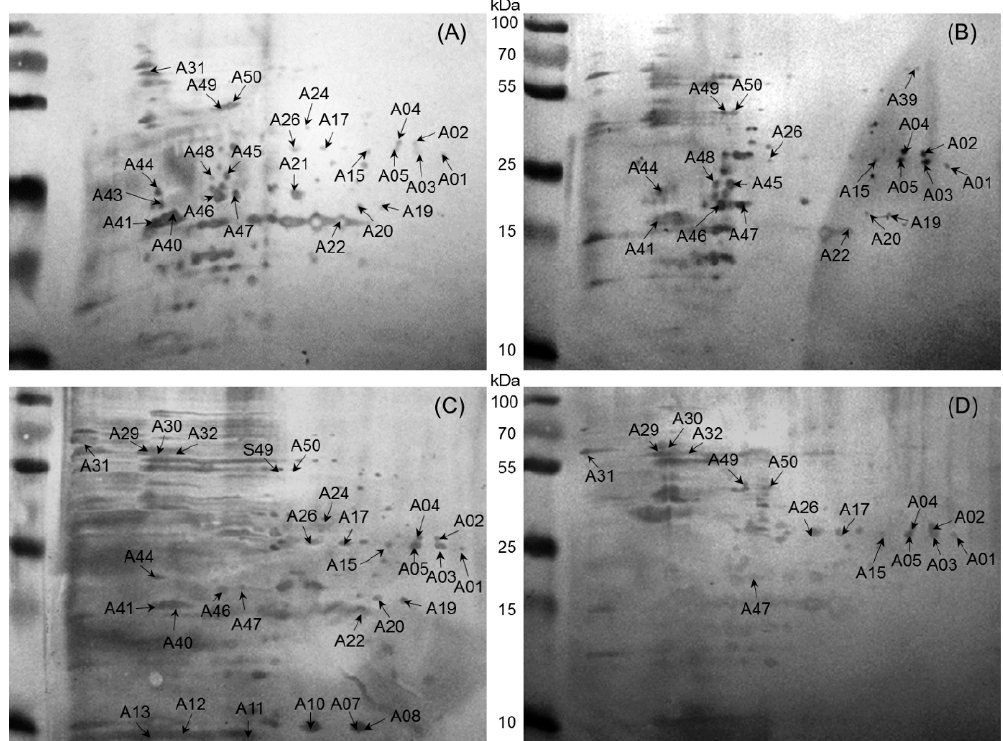
Figure 2. Representative two dimensional electrophoresis immunoblotting images of whole cell proteins from B. abortus field strain extracts separated on a 12% polyacrylamide gel. The blot was developed using the TMB (3,3 ′ ,5,5 ′ -tetramethylbenzidine liquid substrate) kit after immuno-blotting with serum from ( A ) cattle; ( B ) buffalo; ( C ) sheep; and ( D ) goat and the respective peroxidase-conjugated secondary antibodies.